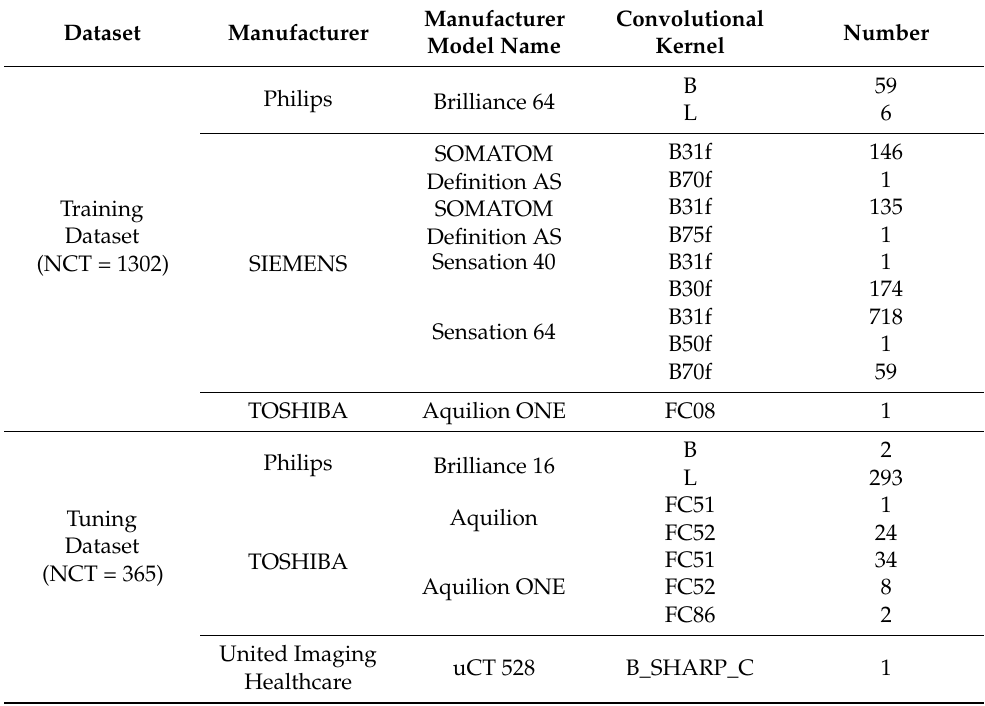
Figure A5. Comparisons of accuracies of the pre-trained models and the proposed model appendix by testing on validation dataset 2. A transfer learning method was used to apply other state-of-the-art pre-trained models to predict the malignancy and invasiveness of GGNs. In the pre-trained model development, the parameters in CNN pooling processes were frozen and the parameters in fully connected or classifier layers were trained. In the model training process, the pre-trained models were the configured with the same parameters as the DNN model. Table A1. The statistics of the manufacturer and convolutional kernel for CT images in our